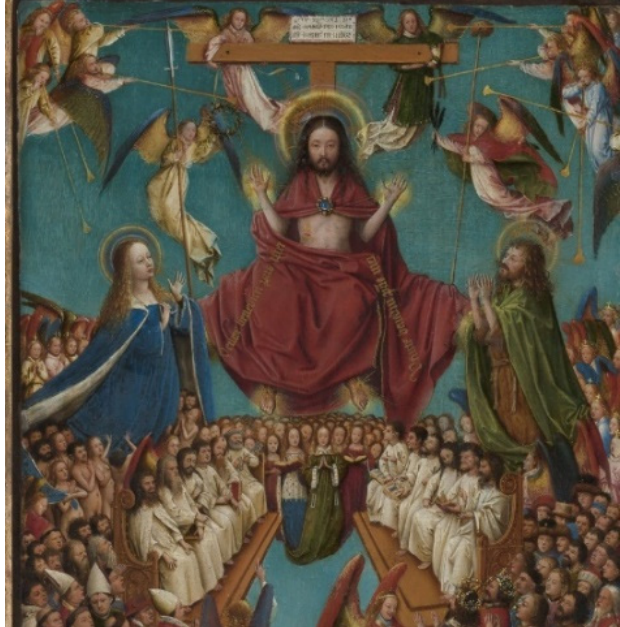
Figure 4. Detail of Figure 1.